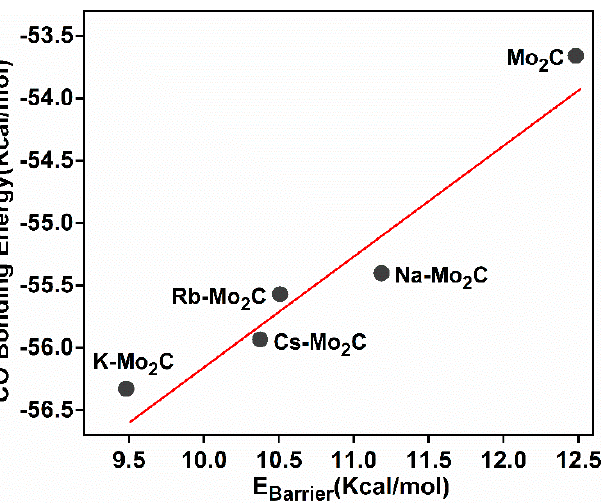
Figure 6. Correlation between activation energy of the CO 2 dissociation and Max Δ E TS (fitting model: y = 2.16x − 26.56; R 2 = 0.90). Table 3. Mulliken charges ( e ) of key atoms in the calculated transition states.